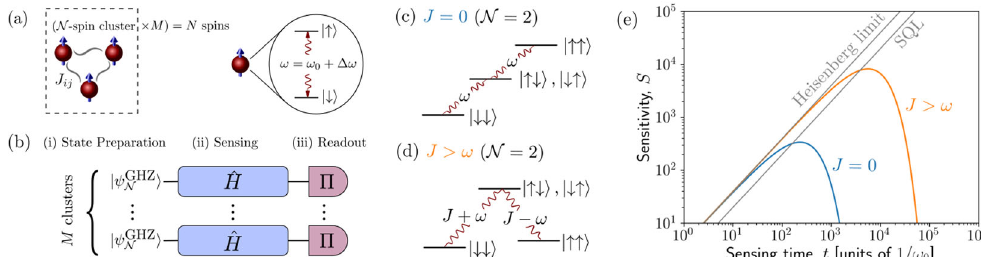
Fig. 1 a We consider estimation of ω — the frequency gap between spin states, "j i and #j i — in a system of N spins (divided into M clusters of N spins). b The frequency estimation scheme. c In the simplest case ( N ¼ 2 ), non-interacting spins ( J = 0) that are coupled to a thermal environment will, at zero-temperature, decay to the ground state ##j i , losing all information about the parameter ω . d A strong ferromagnetic Ising interaction ( J > ω ) will modify the energy level structure so that, at zero-temperature, information about ω can be encoded in the relative phase of the two ground states ""j i and ##j i . e Comparing the orange line to the blue line shows that, even for non-zero temperatures, the sensitivity is enhanced when the spins are strongly interacting (plotted for coupling strength J = 5 ω 0 , inverse temperature β = 1/ ħ ω 0 , and Ohmic spectral density f ( Ω ) = 0.001 × Ω